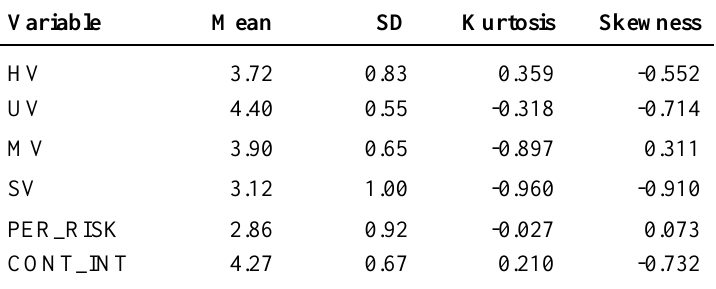
Table 1: Descriptive Statistics